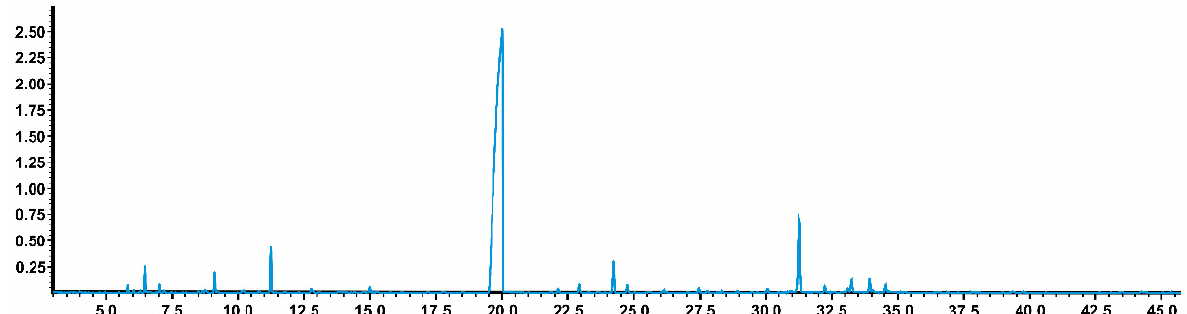
Figure 2. Aniba canelilla essential oil chromatogram. Table 1. Chemical composition of Aniba canelilla essential oil.